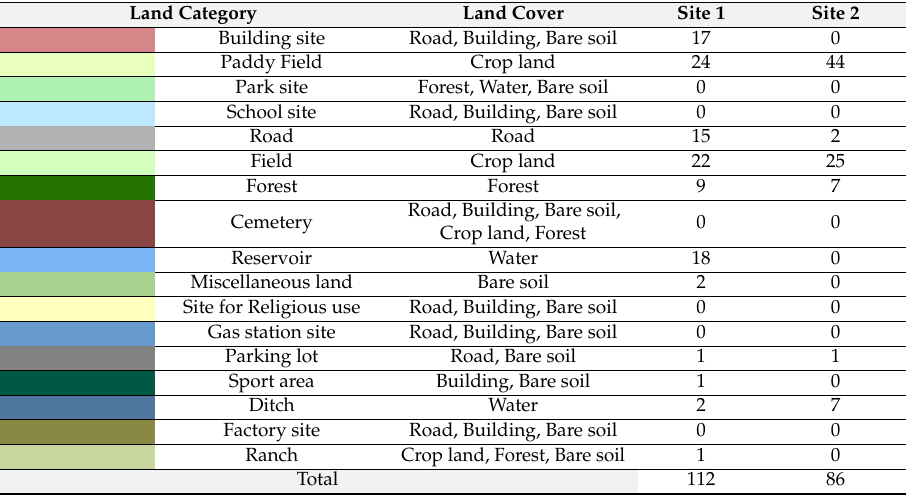
Table 3. Numbers of parcels with discrepancy ratios of 50% or